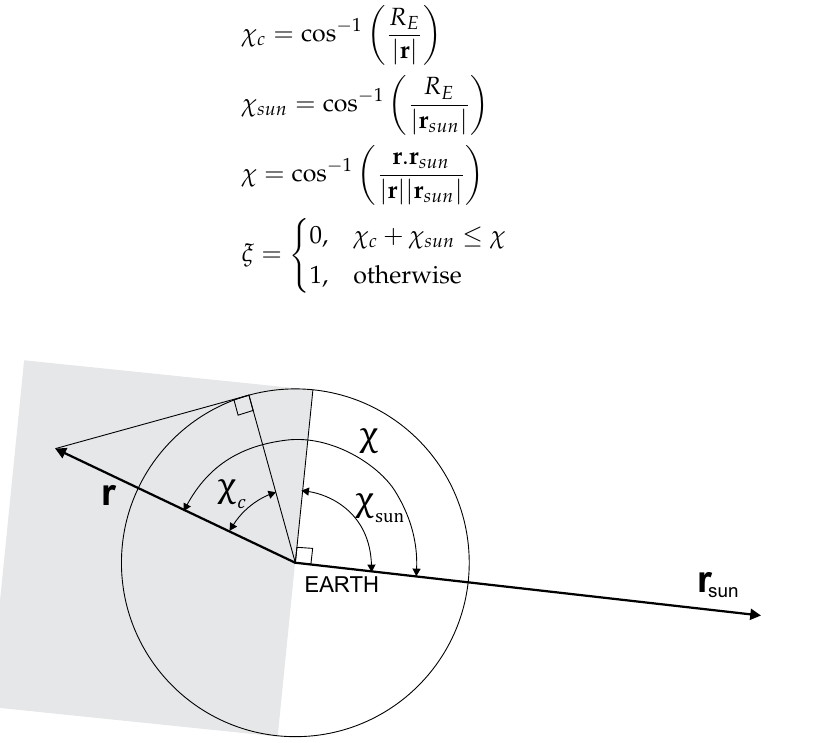
Figure 4. Diagram to estimate the